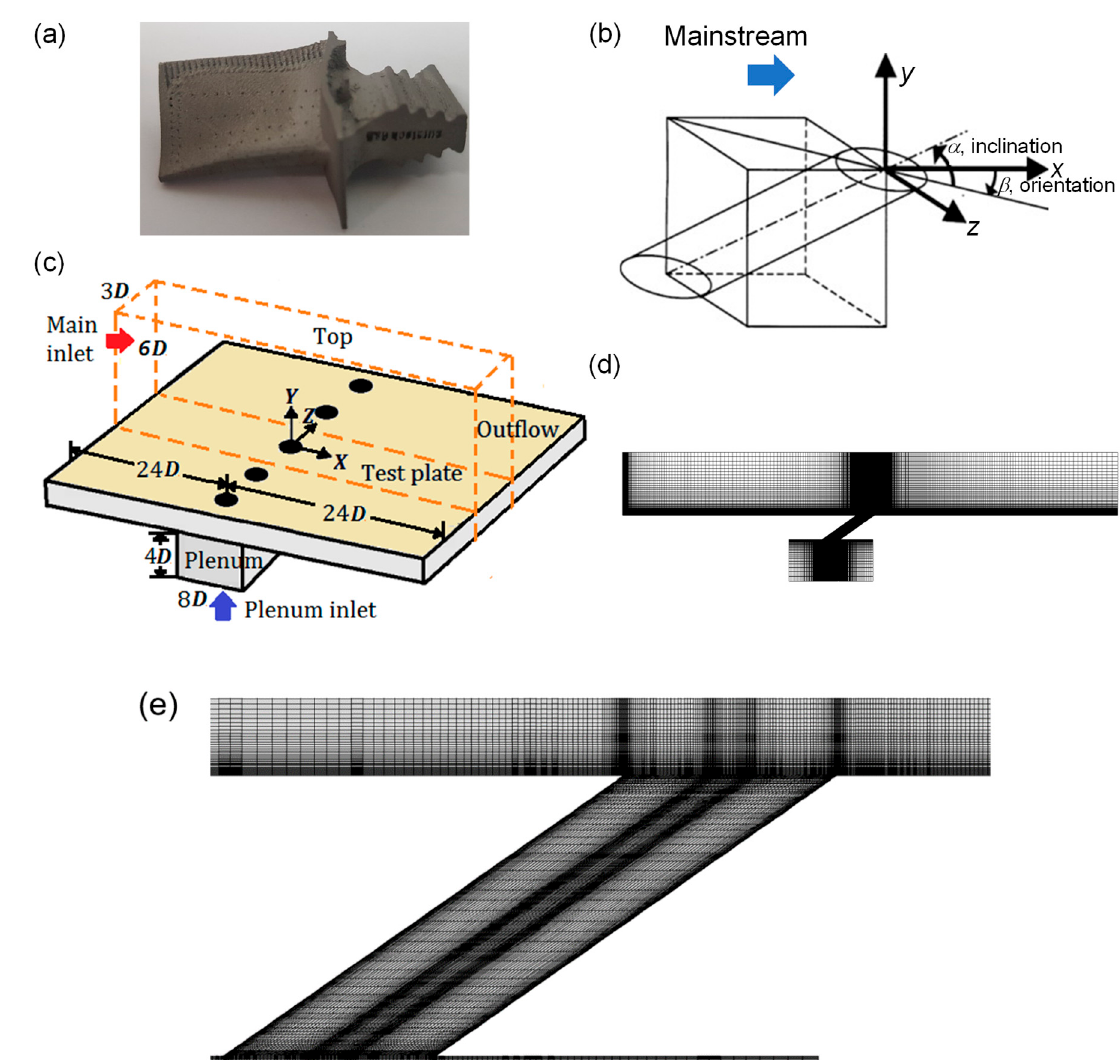
Figure 1. Film cooling geometry and computational domain: ( a ) Gas turbine blade with film cooling holes; ( b ) injection geometry of film cooling; ( c ) computational domain; ( d ) grid system; and ( e ) close-up of the mesh near the hole.